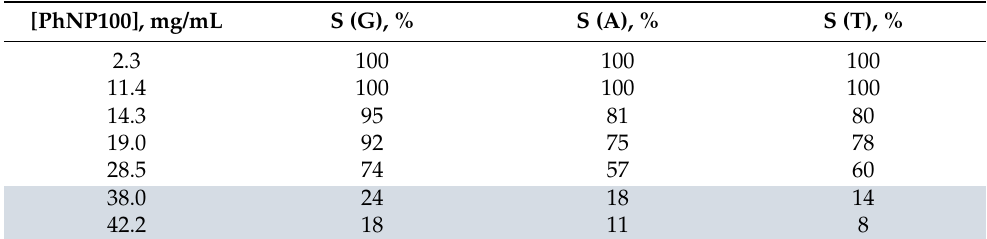
Table 1. The influence of PhNP100 on DPV oxidation signals of guanine (G), adenine (A) and thymine (T). S%—electrochemical coefficient of toxic effect.